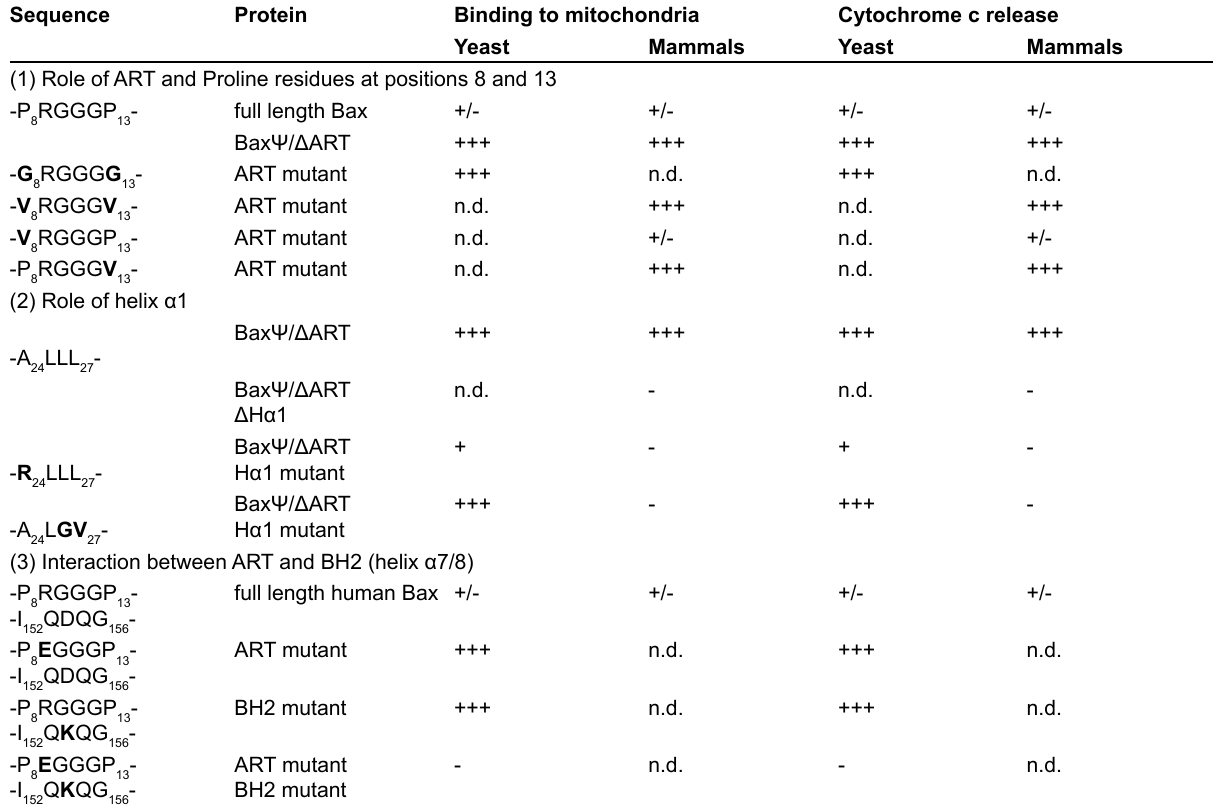
Explor Target Antitumor Ther. 2022;3:128–48 | https://doi.org/10.37349/etat.2022.00076